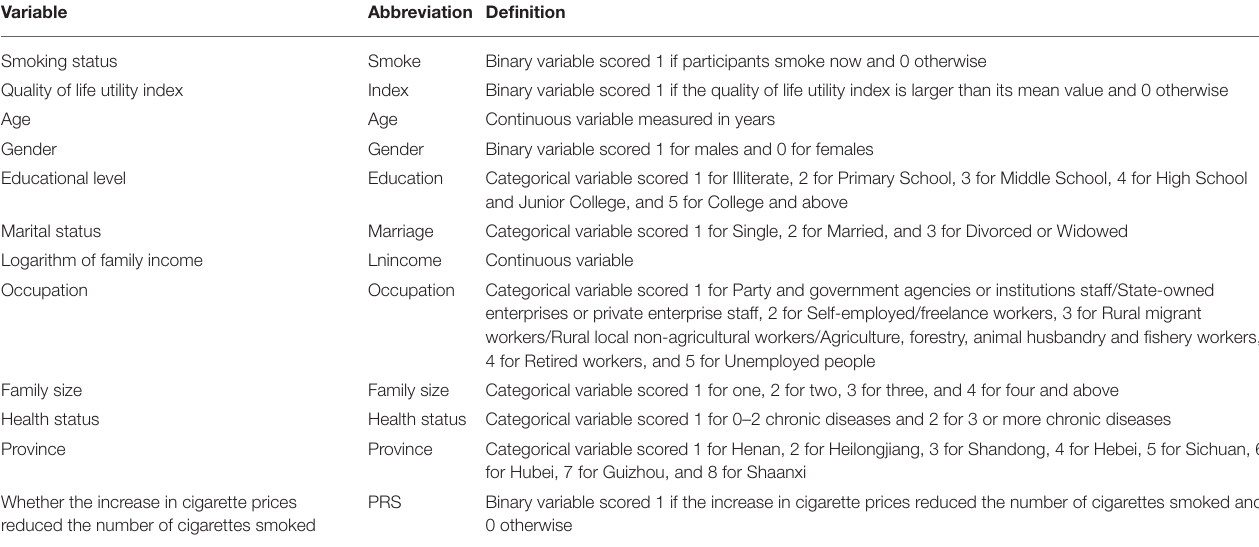
TABLE 1 | The definition and abbreviation of the variables in the